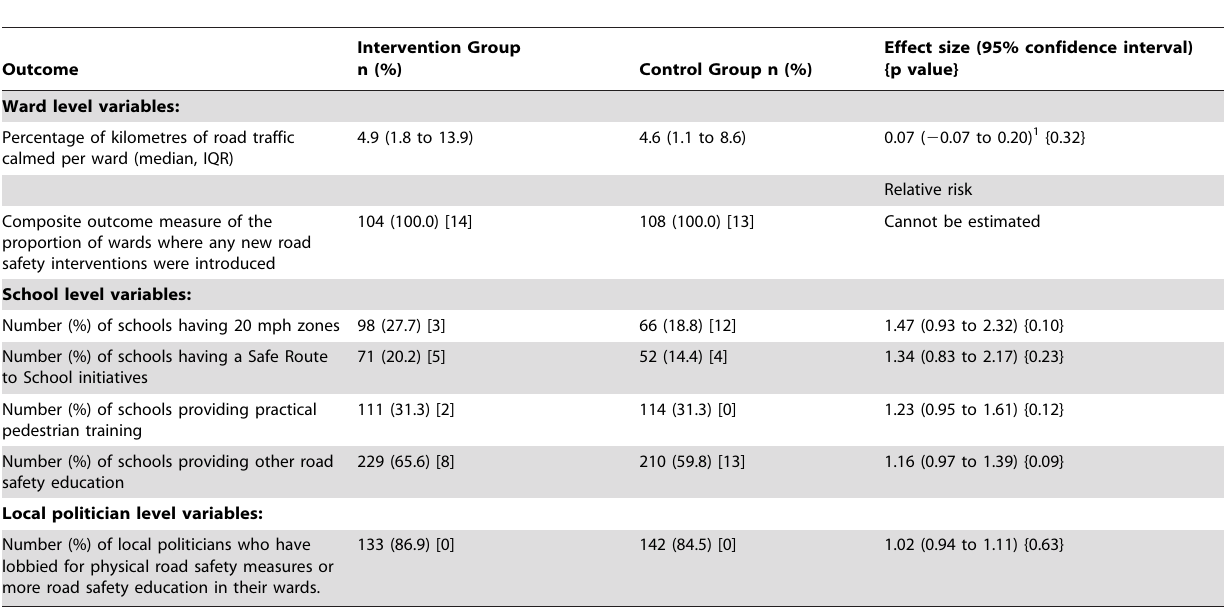
Table 4. Primary outcome measures by treatment group at 25–30 months post intervention.